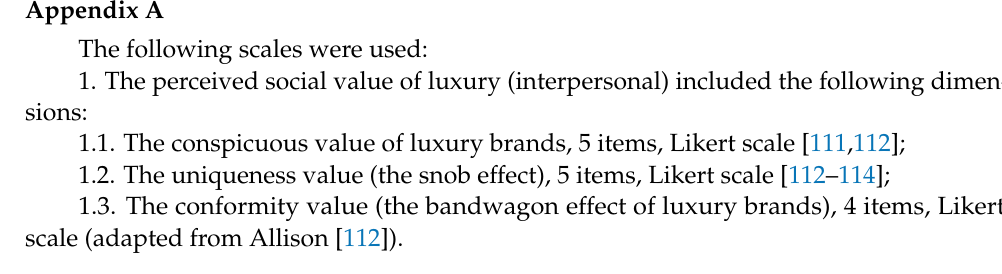
Table A1. The perceived social value of luxury